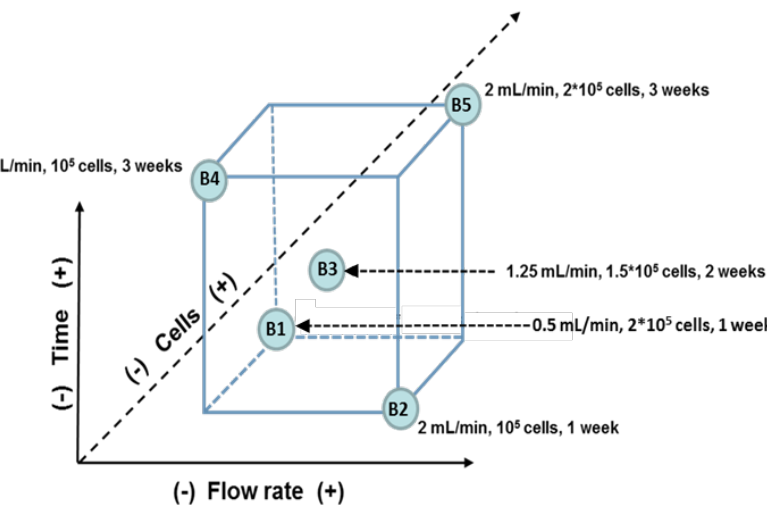
Figure 1. The three-factor, two-level fractional factorial design showing the process space investigated and the experimental conditions chosen for this